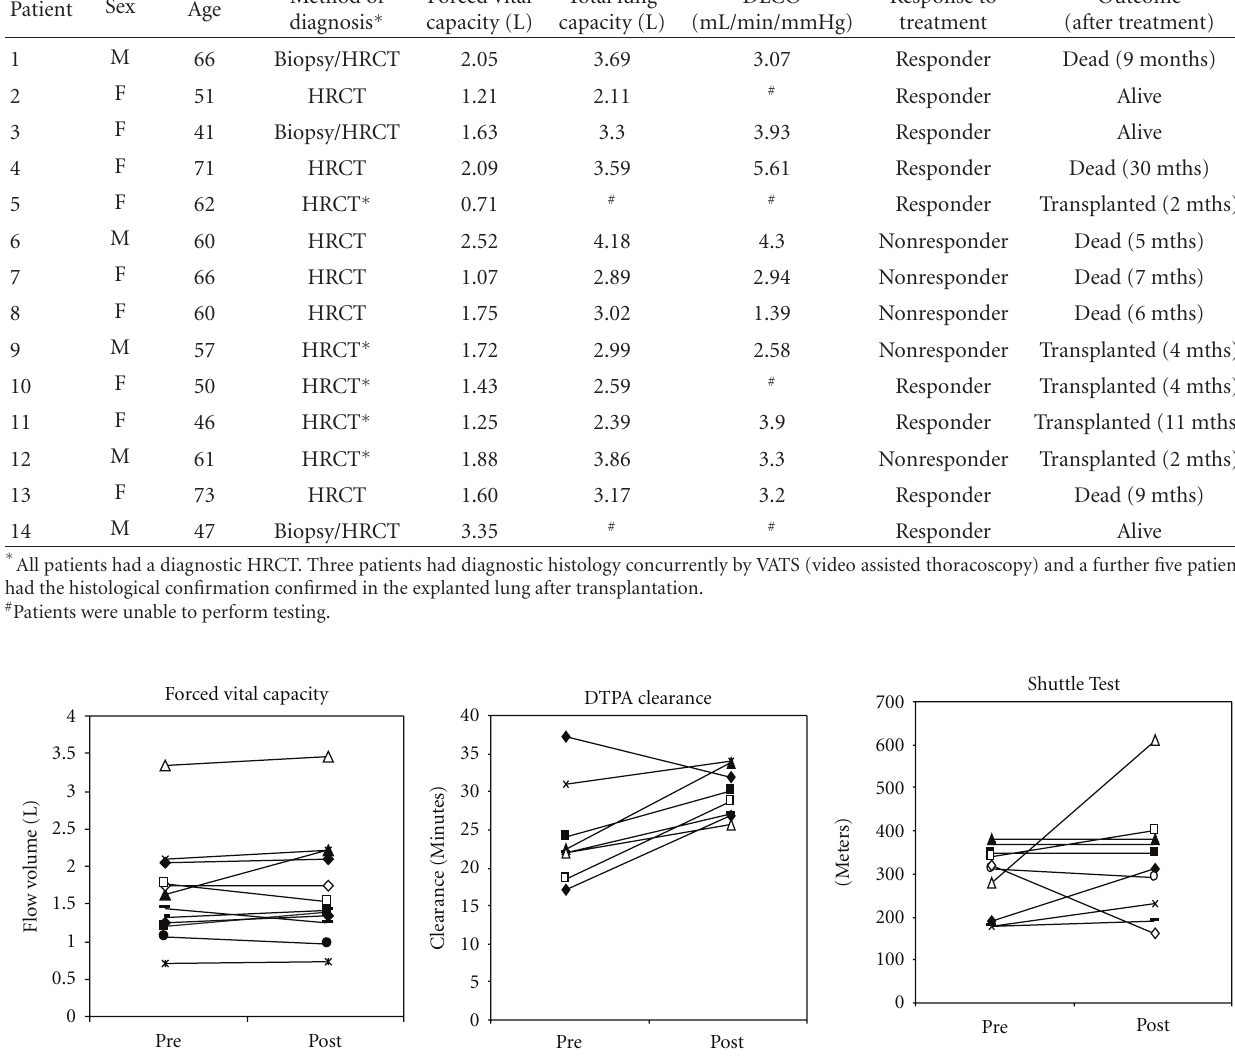
than non-responders (Mean age 56.3 years versus 60.8 years, P = . 21). No significant adverse e ff ects were observed from the